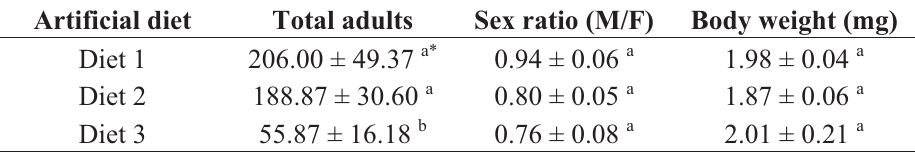
Figure 1. Average number of newly emerged adults of L. africanus fed different diets (Diet 1: wood particle-based diet; Diet 2: cellulose-powder based diet; Diet 3: α -cellulose-based diet). Table 3. Development of L. africanus in three artificial